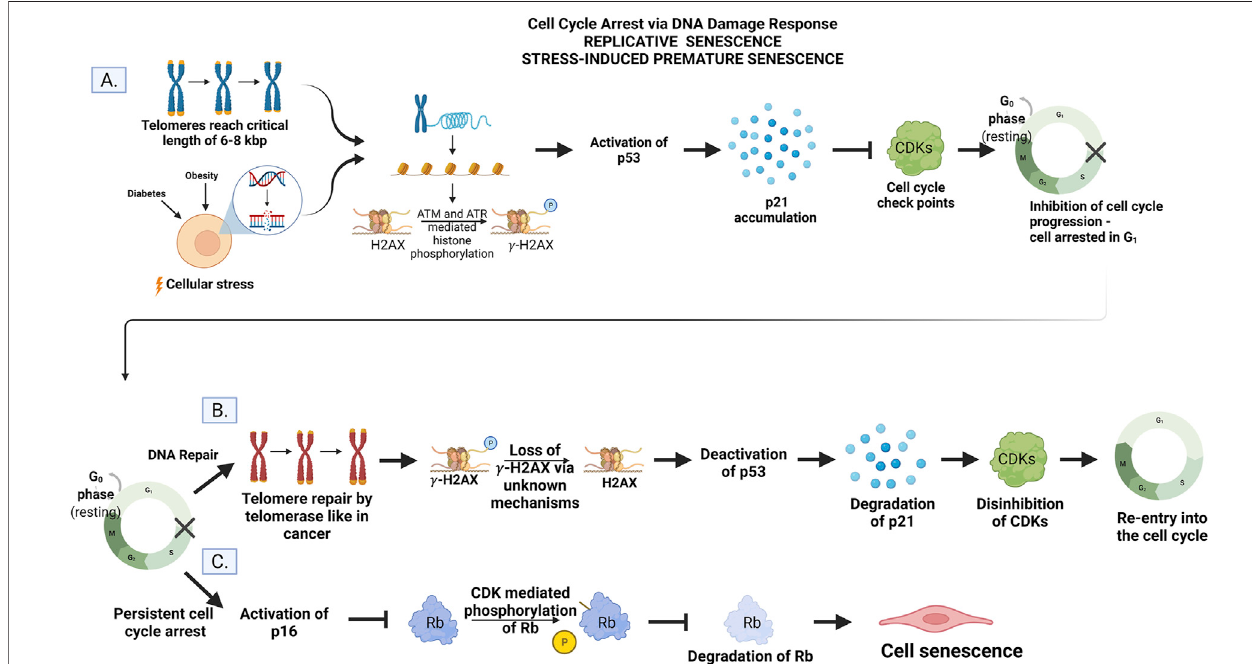
FIGURE 2 |(A) Cell cycle arrest. Telomere shorteningto the critical length of 6 – 8kbp or cellular stress activates ATM and ATR to mediate histone phosphorylation of H2AX to gamma-H2AX. The accumulation of gamma-H2AX activates p53 and upregulates the gene p21. Inhibition of CDKs by p21 prevents progression of the cell cycle conditionally. (B) DNA repair and re-entry into the cell cycle. The addition of DNA to telomere ends by telomerase instigates the loss of histone phosphorylation via unknownmechanisms.Thep53/p21pathwaysarethendeactivated,p21isdegraded,andCDKsaredisinhibitedallowingthecelltore-enterandprogressthrough the cell cycle. (C) Persistent cell cycle arrest leads to senescence. The DNA damage is unable to be repaired by the cell leading to the activation of the p16 gene. Phosphorylation and subsequent degradation of Rb by CDKs are inhibited. Rb activity instigates permanent exit from the cell cycle but not cell death (senescence) via unknown mechanisms. Created by with